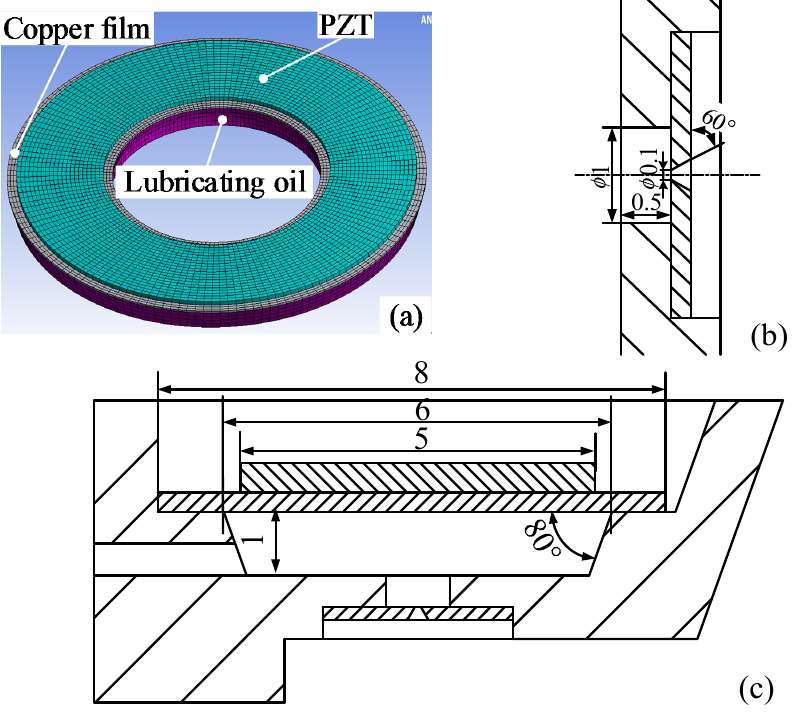
Figure 3. The model and main dimension of the micro-jet (unit: mm): ( a ) the whole finite element model; ( b ) the nozzle part; ( c ) the simplified two-dimensional model.